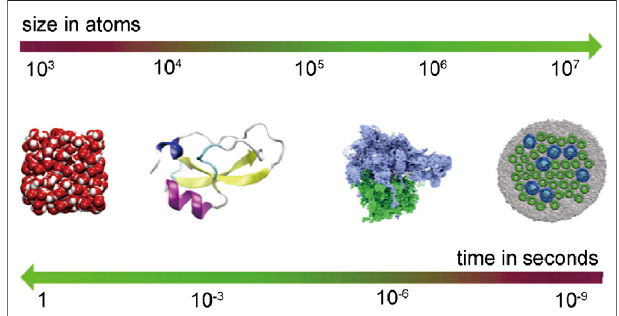
FIGURE 2 | Typical relationship between time scale and spatial scale in the classical molecular dynamics framework (Cai and Christophe, 2013) (from left to right: water molecules; an enzyme; the ribosome; a 25-million-atom patch of the photosynthetic membrane of purple bacteria).